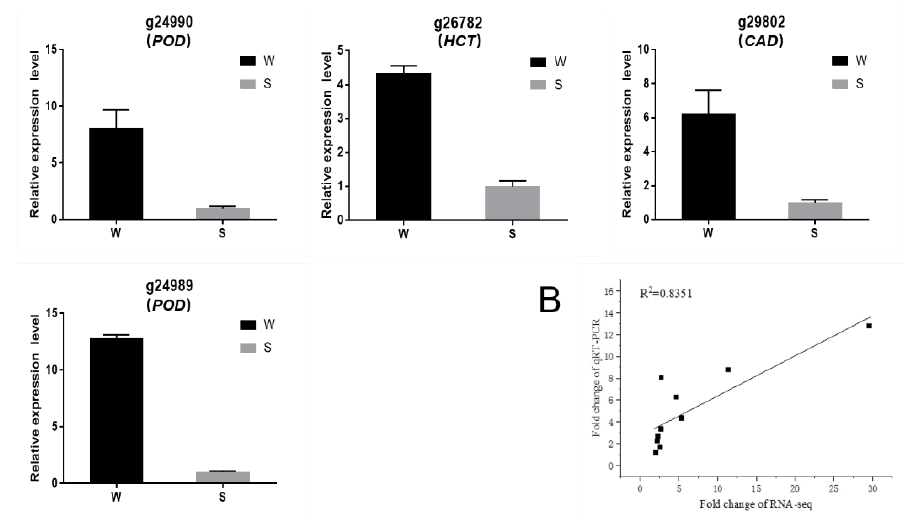
Figure 8. The qRT-PCR of differentially expressed genes. ( A ) Expression of 10 differential genes in two genotypes of sweetpotato blades. ( B ) Correlation analysis of qRT-PCR and RNA-seq. Note: W: Wan1314-6; S: Shangshu19.